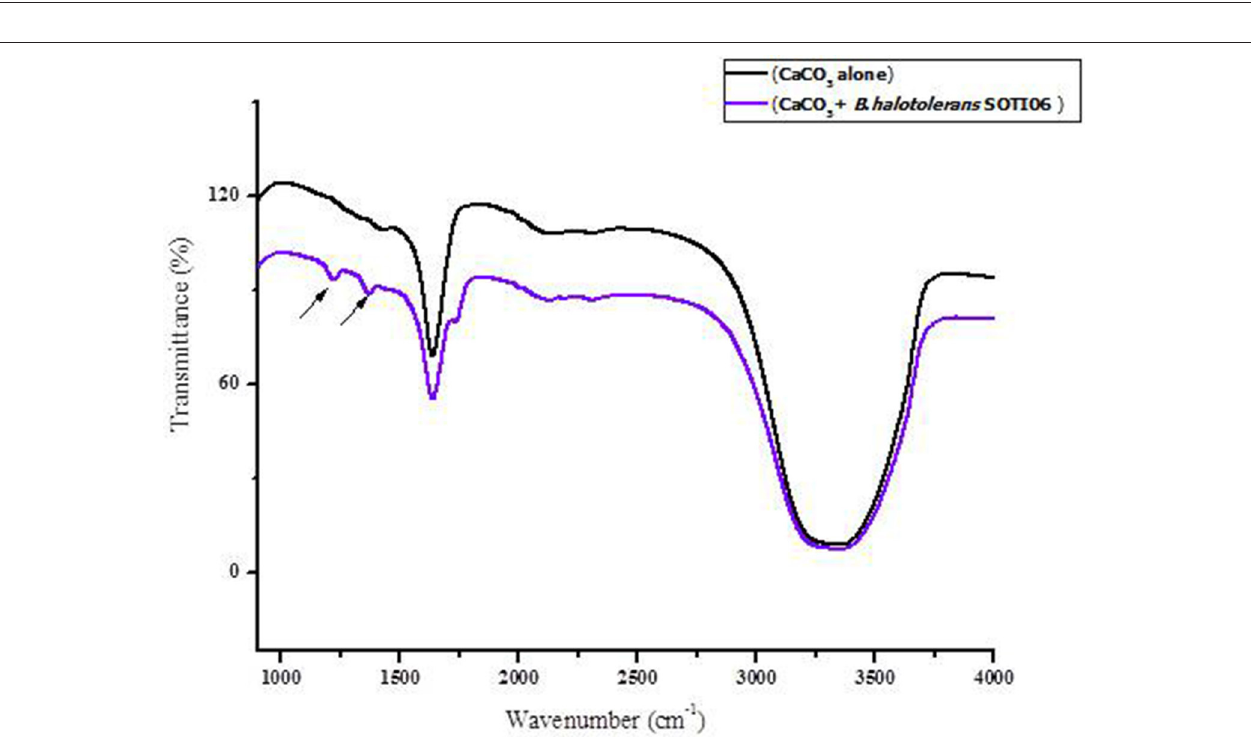
FIGURE 7 | FT-IR spectrum of calcite dissolution by Brevibacterium sp. SOTI06. The spectra in black color indicates control (CaCO 3 alone) whereas purple color indicates the Brevibacterium sp. SOTI06 inoculated sample.